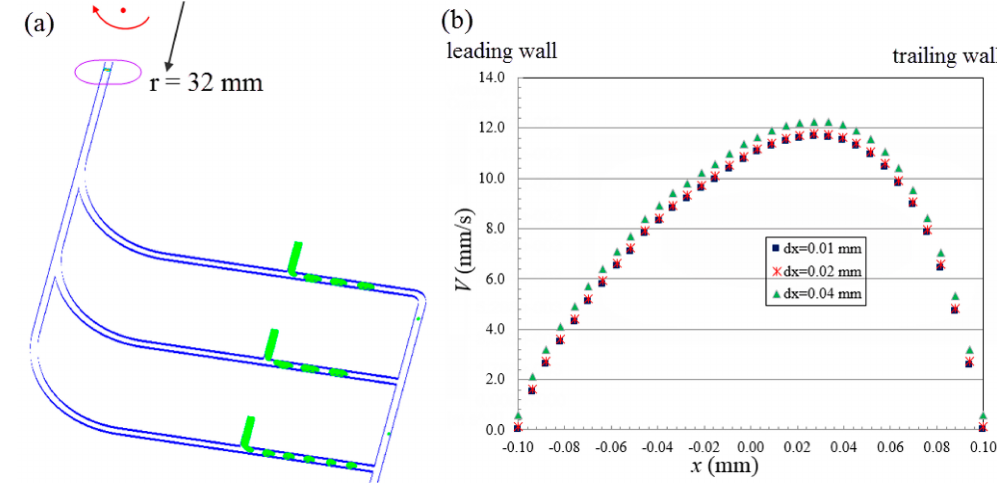
Figure 3. ( a ) Generation of water-in-oil droplets in the centrifugal microfluidic system when Ω = 20 rad/s. ( b ) Throughflow velocity profile across the center line of microchannel along transversal direction with different size of mesh grids at downstream located 32 mm from the center of rotation.